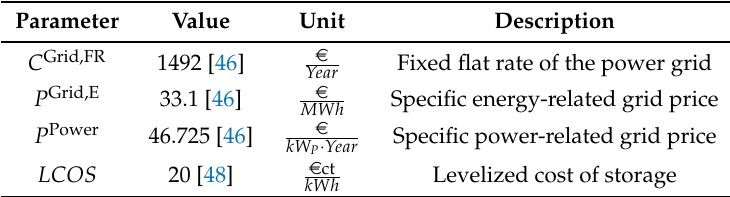
Table 1. Assumed grid costs and LCOS in the